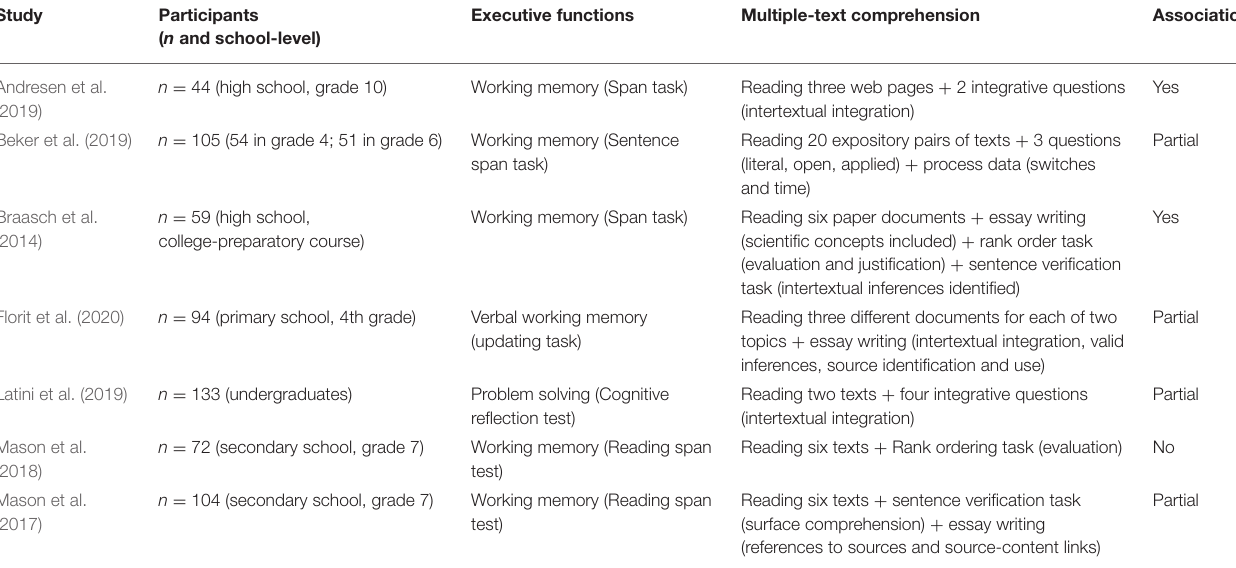
TABLE 1 | Studies presenting direct evidence on the association between executive functions and multiple-text comprehension.